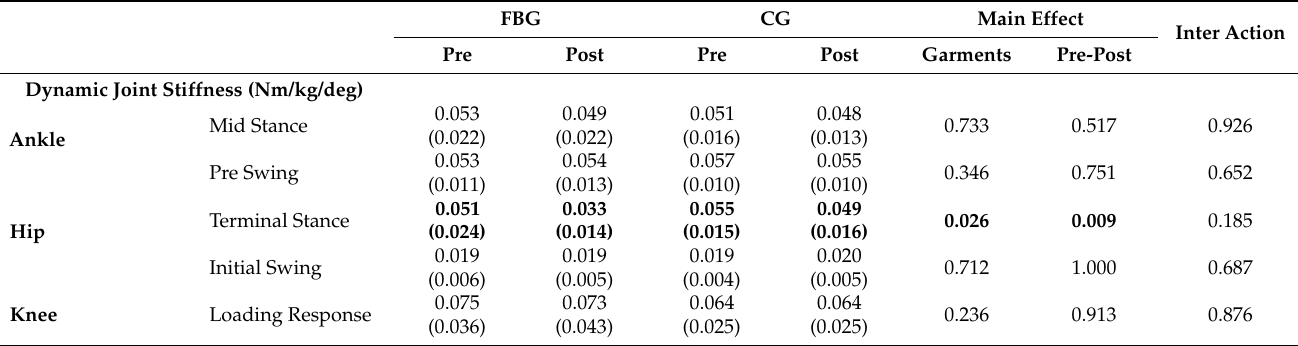
Table 7. Dynamic joint stiffness during walking under two garments condition, i.e., effect of wearing comparison FBG and CG. The FBG group had significantly lower Hip Dynamic joint stiffness values in the Terminal stance than the CG groups. average (SD), two-way ANOVA, p values < 0.05 are